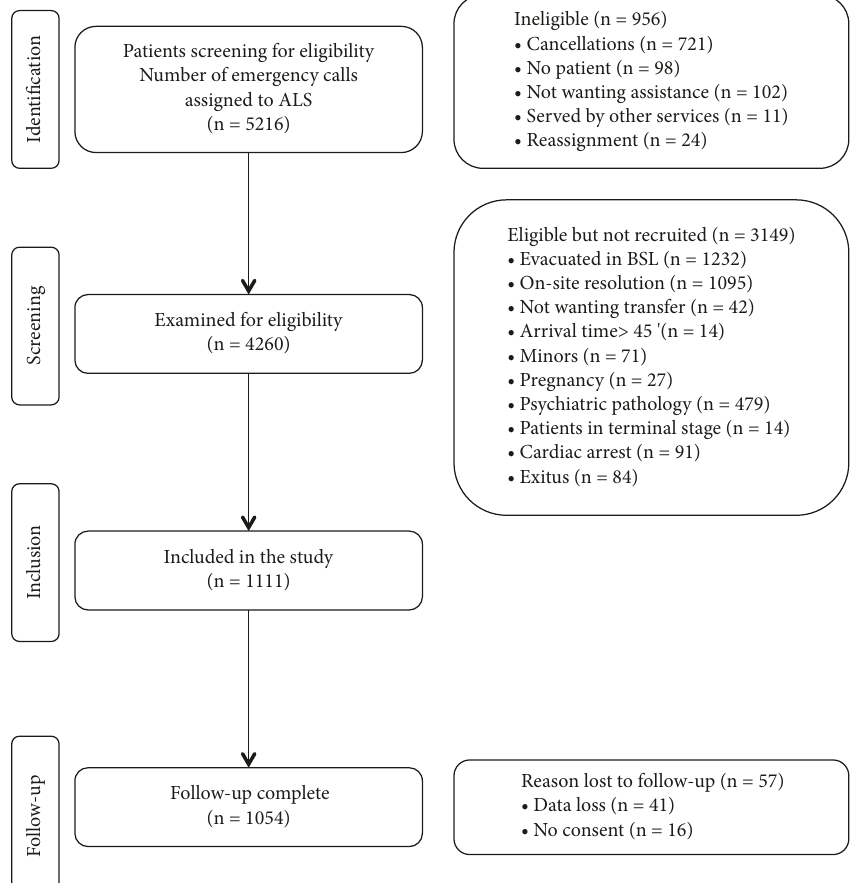
Figure 1: Flow chart of patients recruited to the